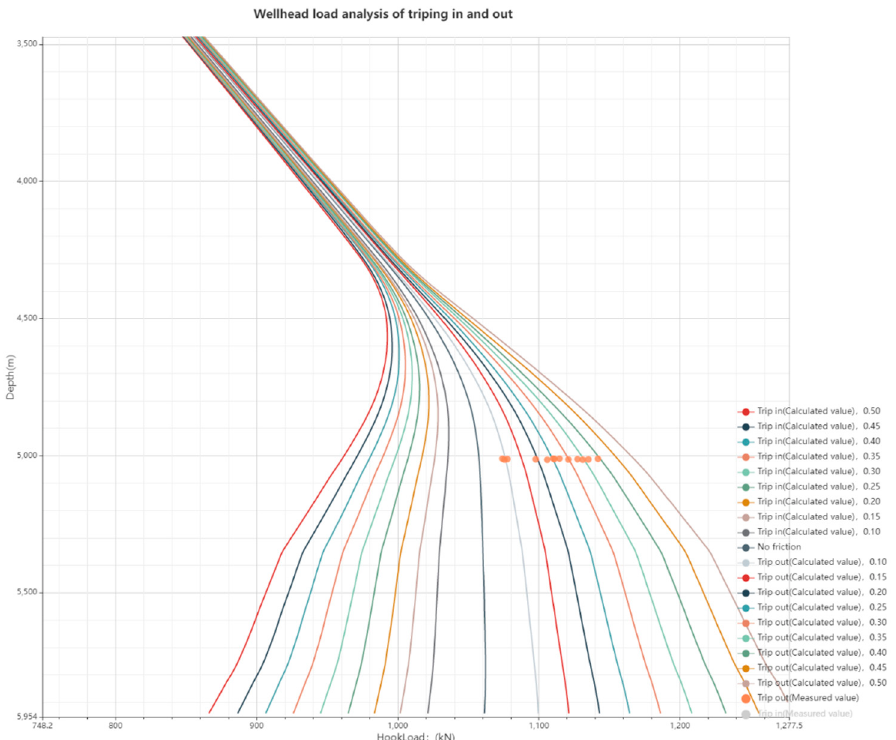
Figure 11. The deviation of the measured POOH hookload value before stuck for well N.